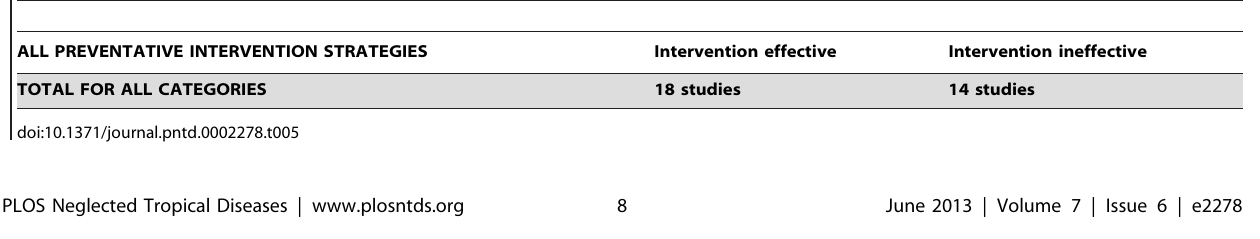
Table 5. Summary table of all preventative interventions.